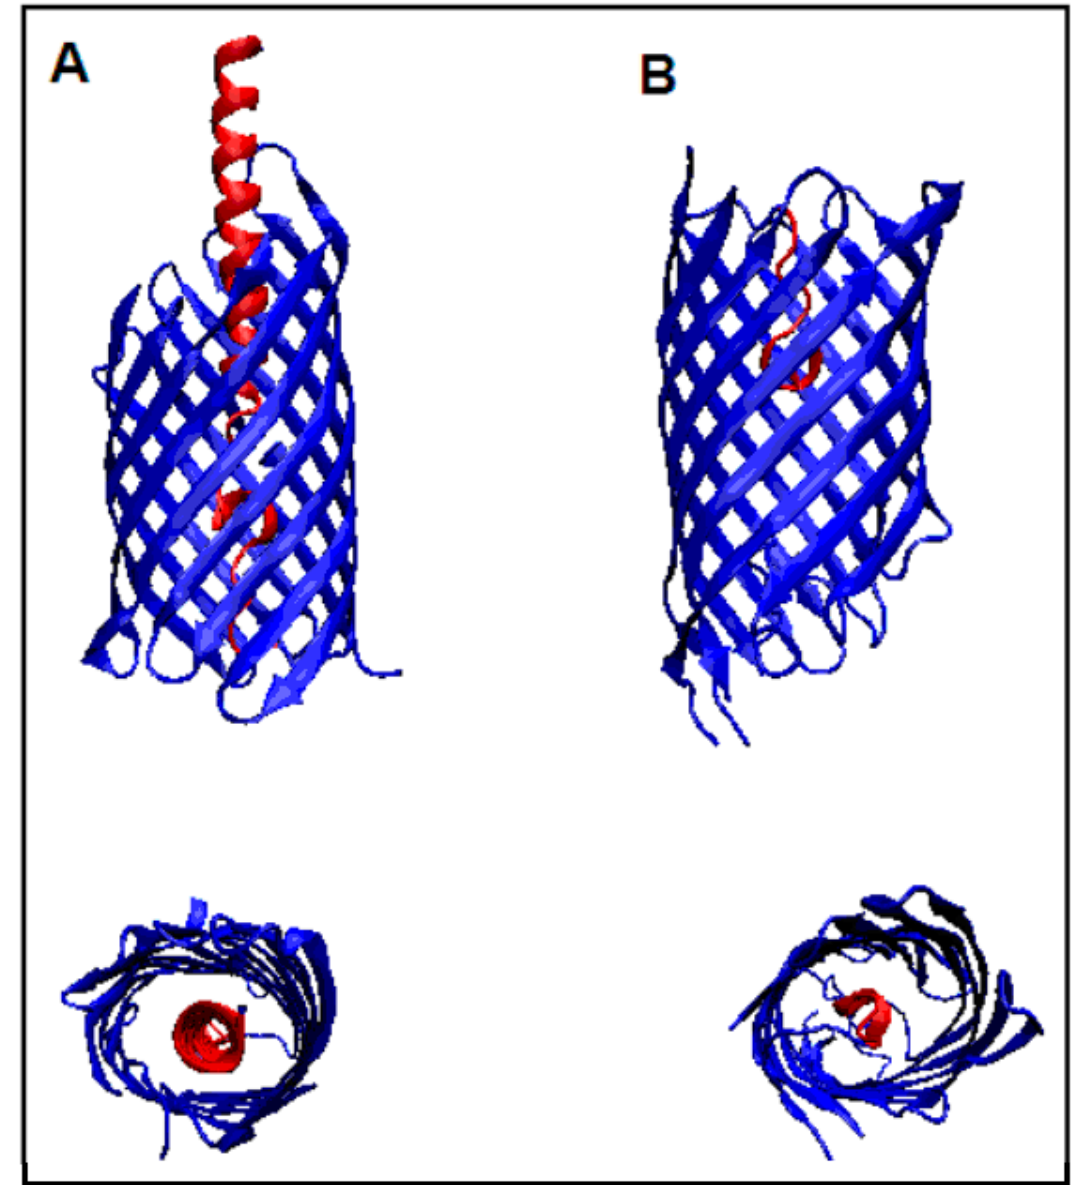
Figure 10. A 3D presentation of the proteins referred to as autotransporters in two different projections. Parts distinguished as red are “passengers”. ( A ) 3AEH and ( B ) 2QOM.